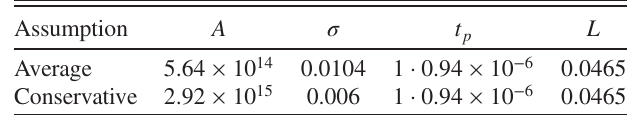
FIG. 6. Contour plot of ϵ versus the number of terms in the rms series m on the abscissa and Π 2 in log-log scale on the ordinate.